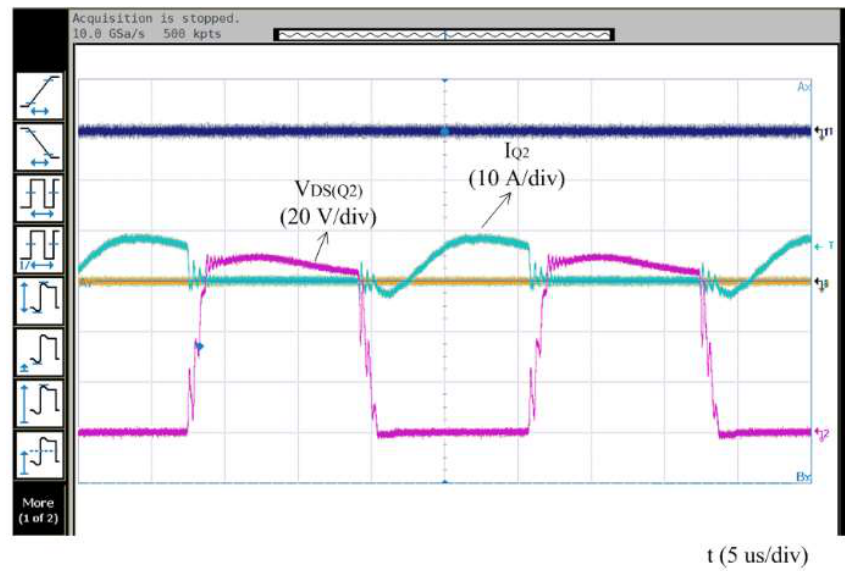
Figure 13. The waveform of another two-stage converter, boost and push–pull. The load is 130 W. According to Figure 14, the buck voltage is about 22 V in the two-stage converter.